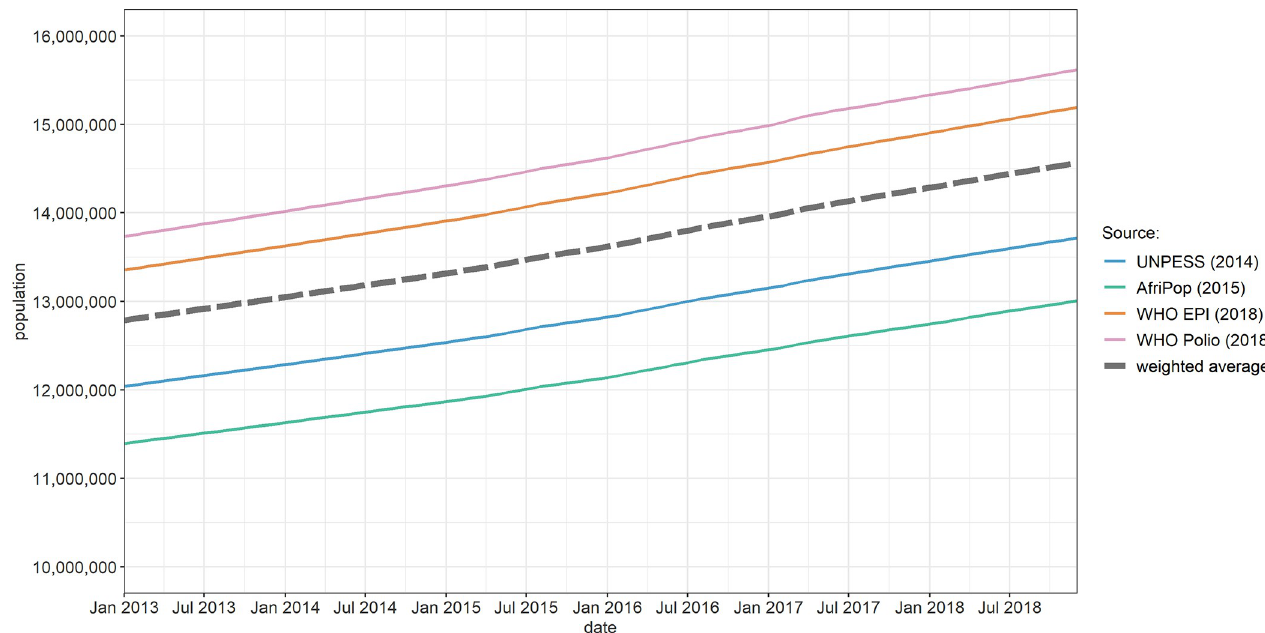
Fig 4. Evolution of total estimated population, by source. UNPESS = United Nations Population Estimation Sample Survey. WHO = World Health Organization.